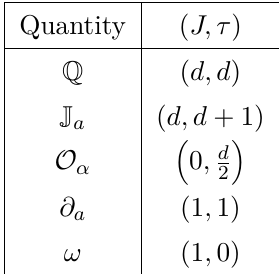
Table 1 . This table tabulates the boost charges and twists of various relevant operators. h i where Φ ( d/ 2) ( u, x ) = lim r d 2 Φ( u, r, x ) . This implies that O ( ω, x ) is a LRO localized r →∞ on the null-ray x on I ± . This assumption then implies that the commutators (3.18) depend only on the Dirac delta function δ ( d ) (cid:0) x − x 0 (cid:1) and its